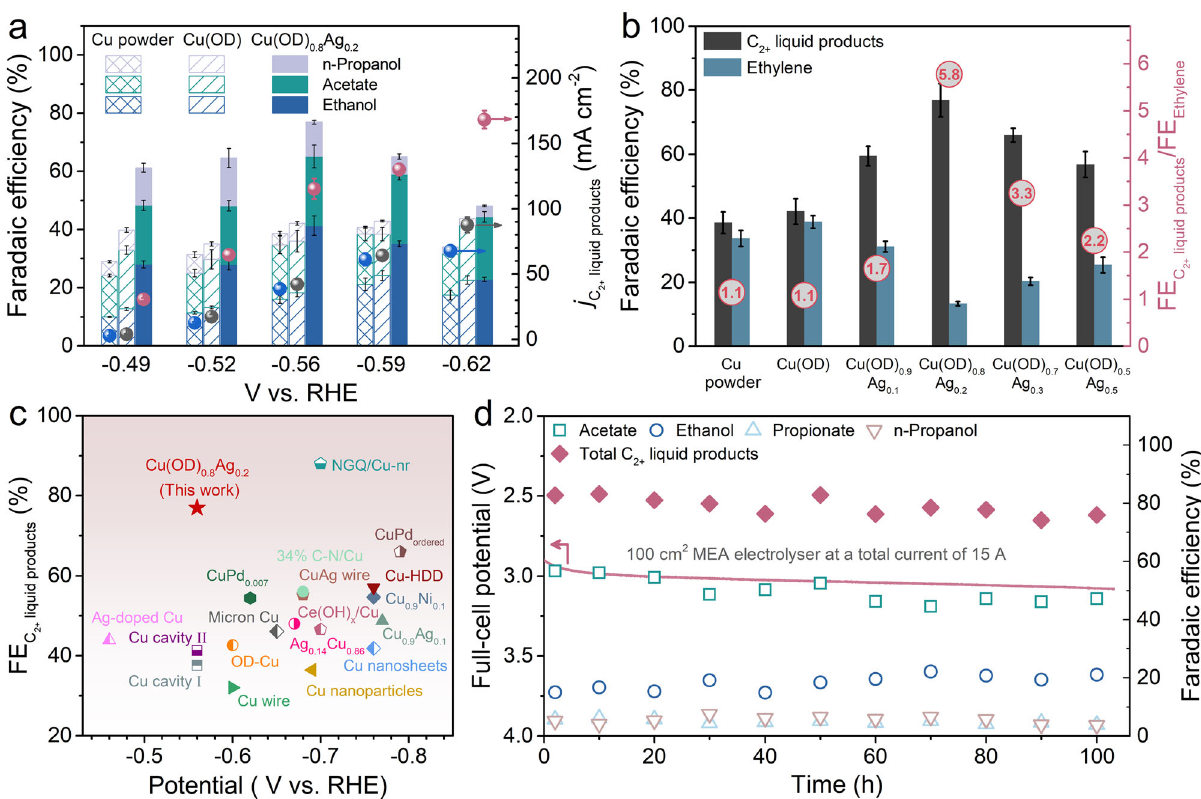
Fig. 1 | Carbon monoxide electroreduction performance. a Faradaic ef fi ciency andtotalcurrentdensitiesofC 2+ liquidproducts(acetate,ethanol,andn-propanol) on polycrystalline Cu powder, Cu(OD), and Cu(OD) 0.8 Ag 0.2 catalysts at various applied potentials in 1M KOH. b Faradaic ef fi ciency of C 2+ liquid products and ethylene on all different catalysts at – 0.56±0.01 V RHE . Numbers in the red circles showthecorrespondingFaradaicef fi ciencyratioofC 2+ liquidproductstoethylene. c Comparison of the maximum C 2+ liquid products FE versus applied potential